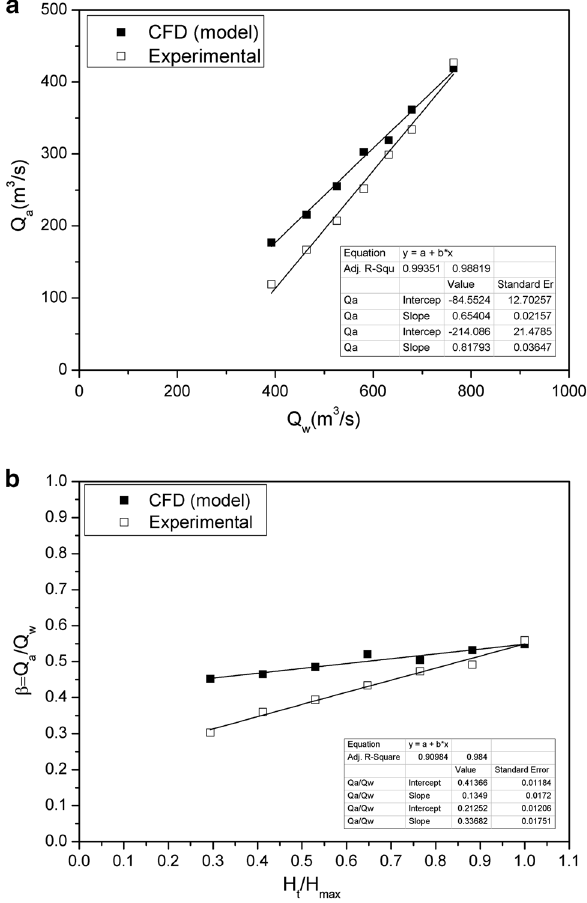
Fig. 5 Comparison of experimental and numerical results for 1/40-scaled model: a air entrainment discharge, b air entrainment